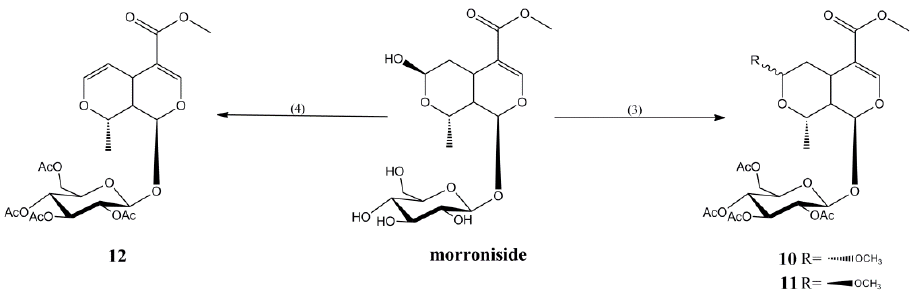
anhydride, 200 °C, 1 h.